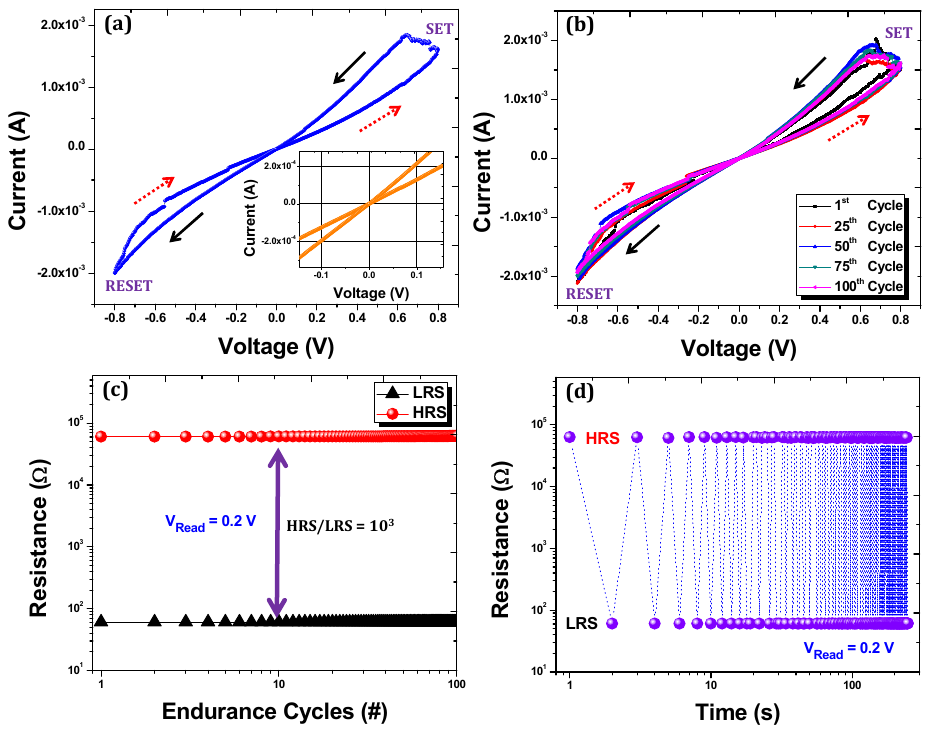
Figure 4. ( a ) Representative current–voltage (I–V) characteristics of the Ag/ZnO/FTO thin film memristive device and ( b ) repetitive I–V characteristics for 100 consecutive cycles. ( c ) Endurance and ( d ) retention characteristics of the developed memristive device. The inset shown in ( a ) represents the zero crossing property of the memristive device. The direction of resistive switching is denoted by arrows.